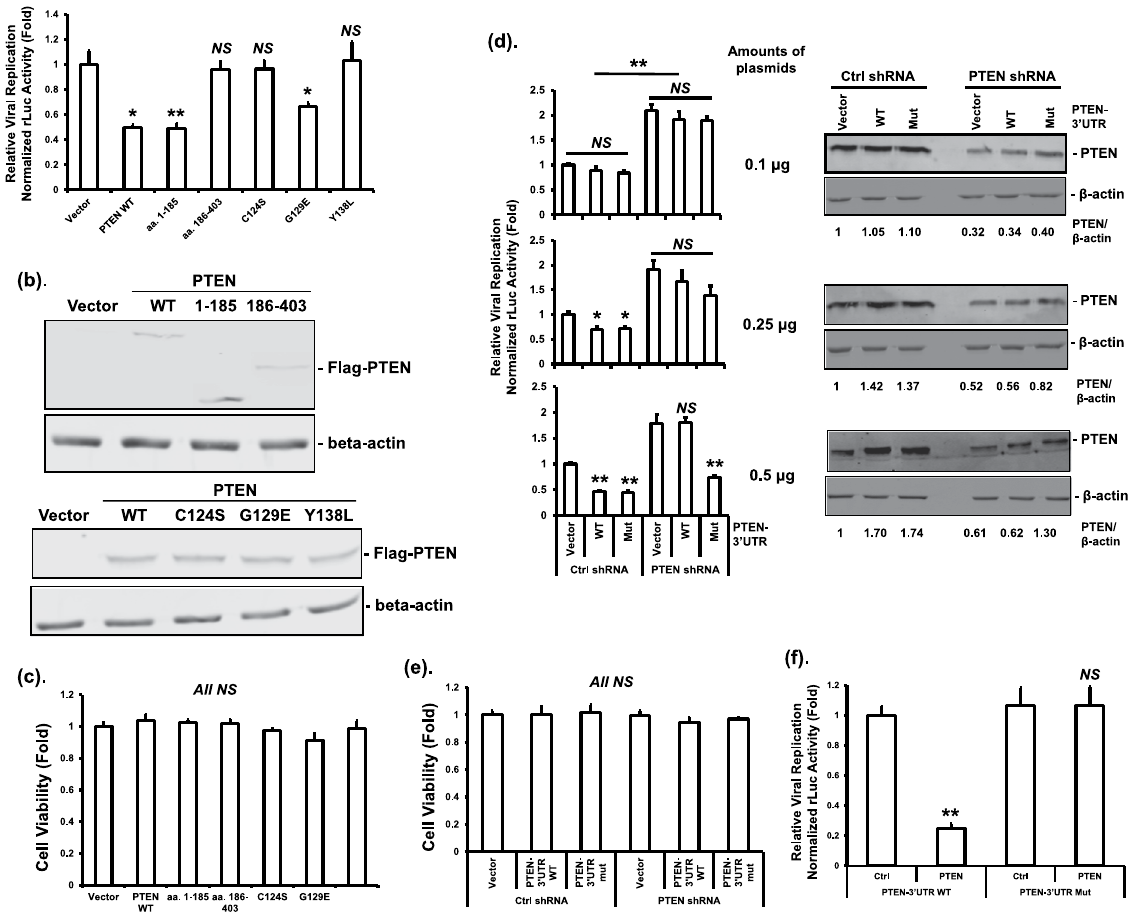
Figure 1. PTEN protein phosphatase activity is required for decreasing HCV RNA level after HCV infection. ( a ) Huh-7.5 cells were transfected with plasmids expressing wild-type Flag-PTEN (PTEN WT), truncated mutants, phosphatase deficient mutants, or empty vector. Forty eight hours after transfection, cells were infected with HCV-2a J6/JFH-1(p7-rLuc-2A) virus at a multiplicity of infection (MOI) of 1. Luciferase assay was performed using the cell lysates 72 hours post-infection (hpi). This experiment was performed three times. ( b ) The protein levels of PTEN proteins and β -actin after transfection were determined by Western blotting using anti-Flag and anti- β -actin antibodies, respectively. ( c ) Cell viability was determined by MTT assay 72 hpi. This experiment was performed three times. ( d ) Huh-7.5 cells expressing an inducible PTEN shRNA or non- silencing control shRNA were treated with 1 μ g/mL of Doxycycline for 48 hours. Cells were then infected with HCV-2a J6/JFH-1(p7-rLuc-2A) virus at an MOI of 1. At 24 hpi, cells were transfected with increasing amounts of plasmids expressing Flag-tagged PTEN with wild-type or mutant 3 ′ UTR, or empty vector. Luciferase assay was performed 48 hours after transfection (left panel). In the right panel, the protein levels of PTEN and β -actin at 36 hours after transfection were determined by Western blotting using anti-PTEN and anti- β -actin antibodies, respectively. Relative PTEN band intensities against β -actin were given underneath each sample. This experiment was performed twice. ( e ) Cell viability was determined by MTT assay in parallel with luciferase assay. This experiment was performed twice. ( f ) Huh-7 cells were co-transfected with plasmids expressing non- silencing control shRNA or shRNA targeting the 3 ′ UTR of PTEN, together with bicistronic RNA interference reporter plasmids with (PTEN-3 ′ UTR WT) or without (PTEN-3 ′ UTR Mut) the shRNA target sequence. Dual luciferase assay was performed 48 hours after transfection. The renilla luciferase (rLuc) activity representing the knockdown efficiency was normalized against firefly luciferase activity driven by a constitutive promoter on the reporter plasmid. Luciferase activities were expressed as fold changes relative to vector control. The statistical differences between samples were demonstrated as * if p ≤ 0.05, ** if p ≤ 0.01, or NS for not significant. This experiment was performed three